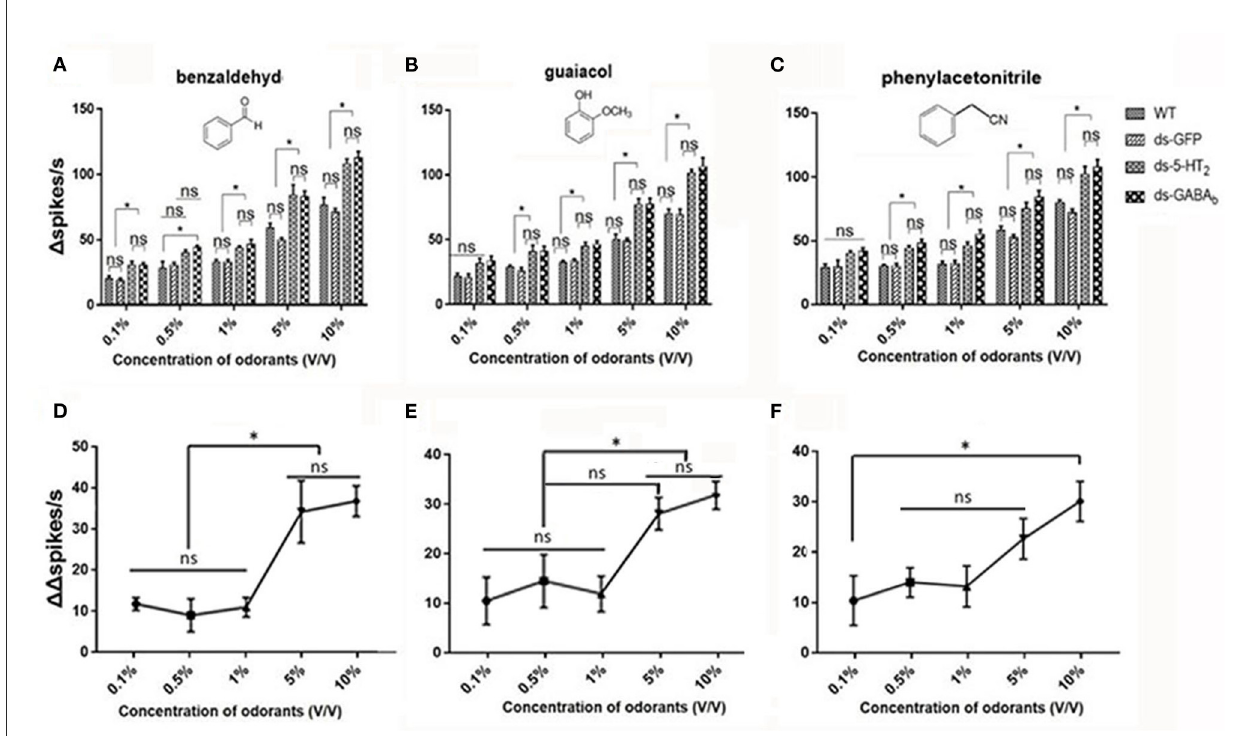
FIGURE7 ORNs in the antennal basiconic sensilla of wild-type, ds-GFP, ds-5-HT 2 , and ds - GABA b locusts have dose-dependent responses to odorants. (A) The 1 spikes/s numbers of Ba6 ORNs of locusts (WT, wild-type locusts; ds-GFP, locusts injected with ds-GFP; ds-5-HT ds- Lmig 5-HT 2 ; ds-GABA b , locusts injected with ds- Lmig GABA b ) in response to benzaldehyde. (B) The 1 spikes/s numbers of Ba6 ORNs of WT, ds-GFP, ds-5-HT 2 , and ds-GABA b locusts in response to guaiacol. (C) The 1 spikes/s numbers of Ba6 ORNs of WT, ds-GFP, ds-5-HT 2 , and ds-GABA b locusts in response to phenylacetonitrile. (D–F) The change of 1 spikes/s numbers (represented by ( 11 spikes/s) of Ba6 ORNs) in response to the three odorants between ds-5-HT 2 or ds-GABA b and WT or ds-GFP. Values are the mean ± SEM, n = 5 per group. * p < 0.05, one-way ANOVA with Tukey’s post-hoc tests. ns, no significant